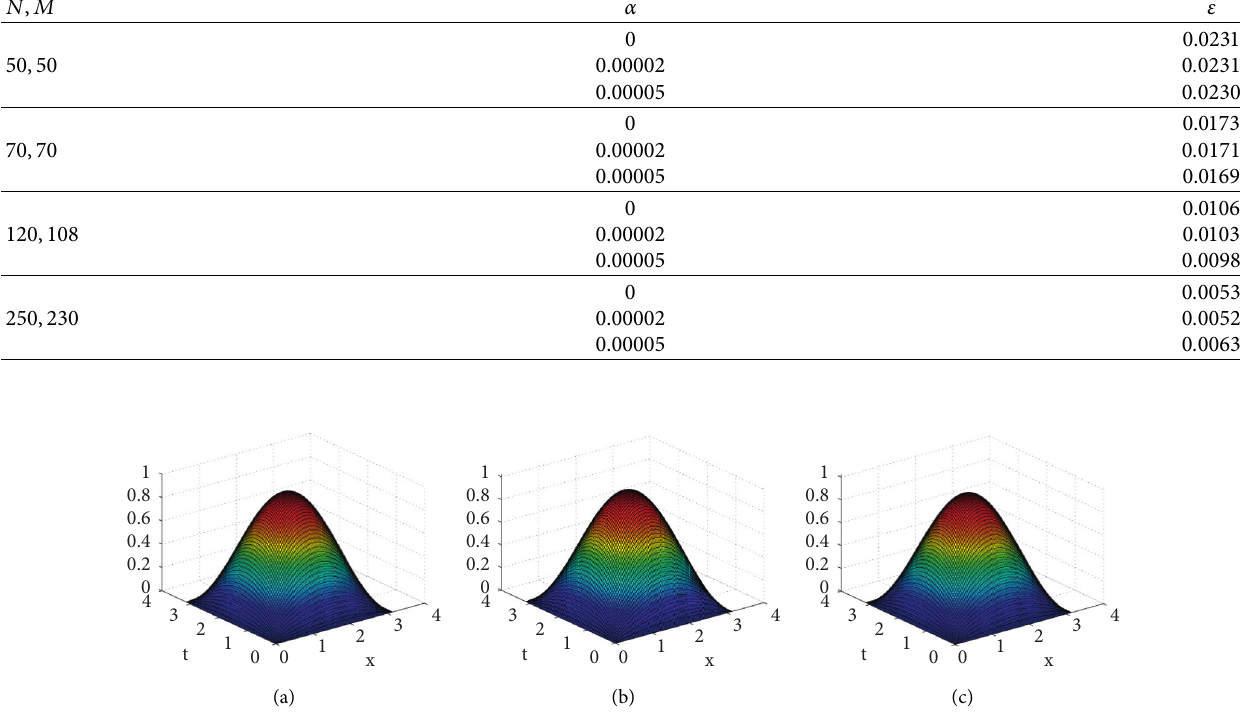
Table 2: Error analysis for system (22) with τ � 1/ N and h � 1/ M .